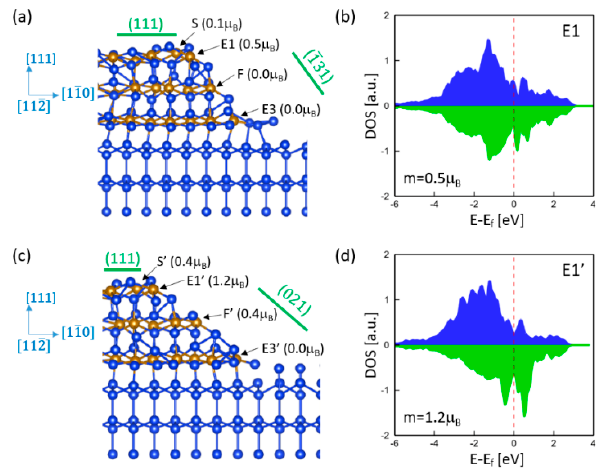
Figure 7. Atomic structure and spin moments of γ -FeSi 2 /Si(111) epitaxial nanoislands with ( a ) a (1(cid:3364)31) facet and ( c ) a (021) facet. The edges are oriented along the [112(cid:3364)] direction. DOS of Fe atom at ( b ) edge E1 and ( d ) edge E1 ′ .